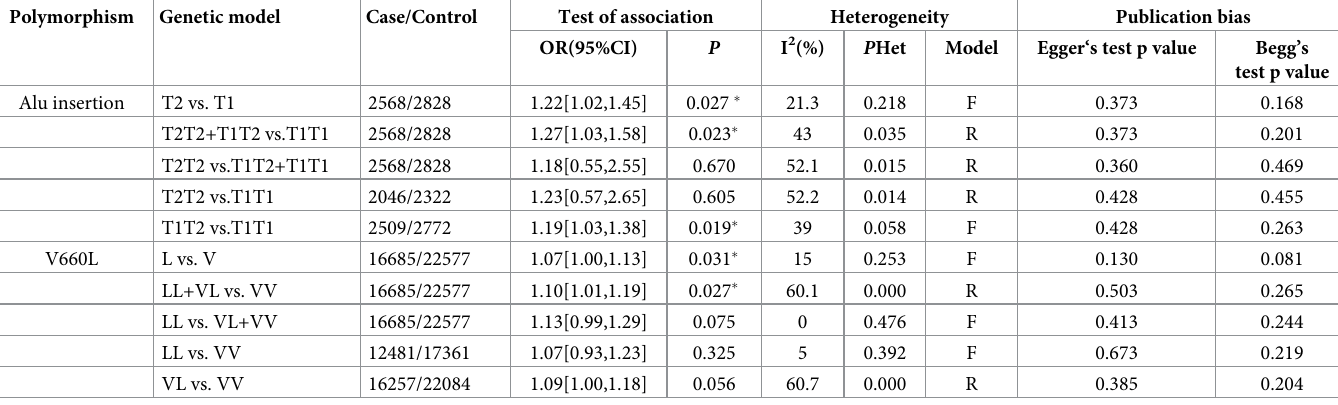
Table 3. Meta-analysis of the association between the PROGINS polymorphism and female reproductive cancer susceptibility. Polymorphism Genetic model